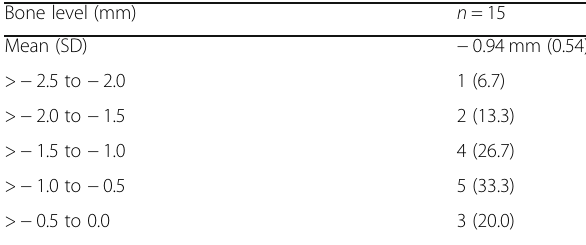
Table 3 Mean value, standard deviation, and frequency distribution (percentages) of marginal bone level at 1 month after restoration placement (T 1 ) Bone level (mm) n = 15